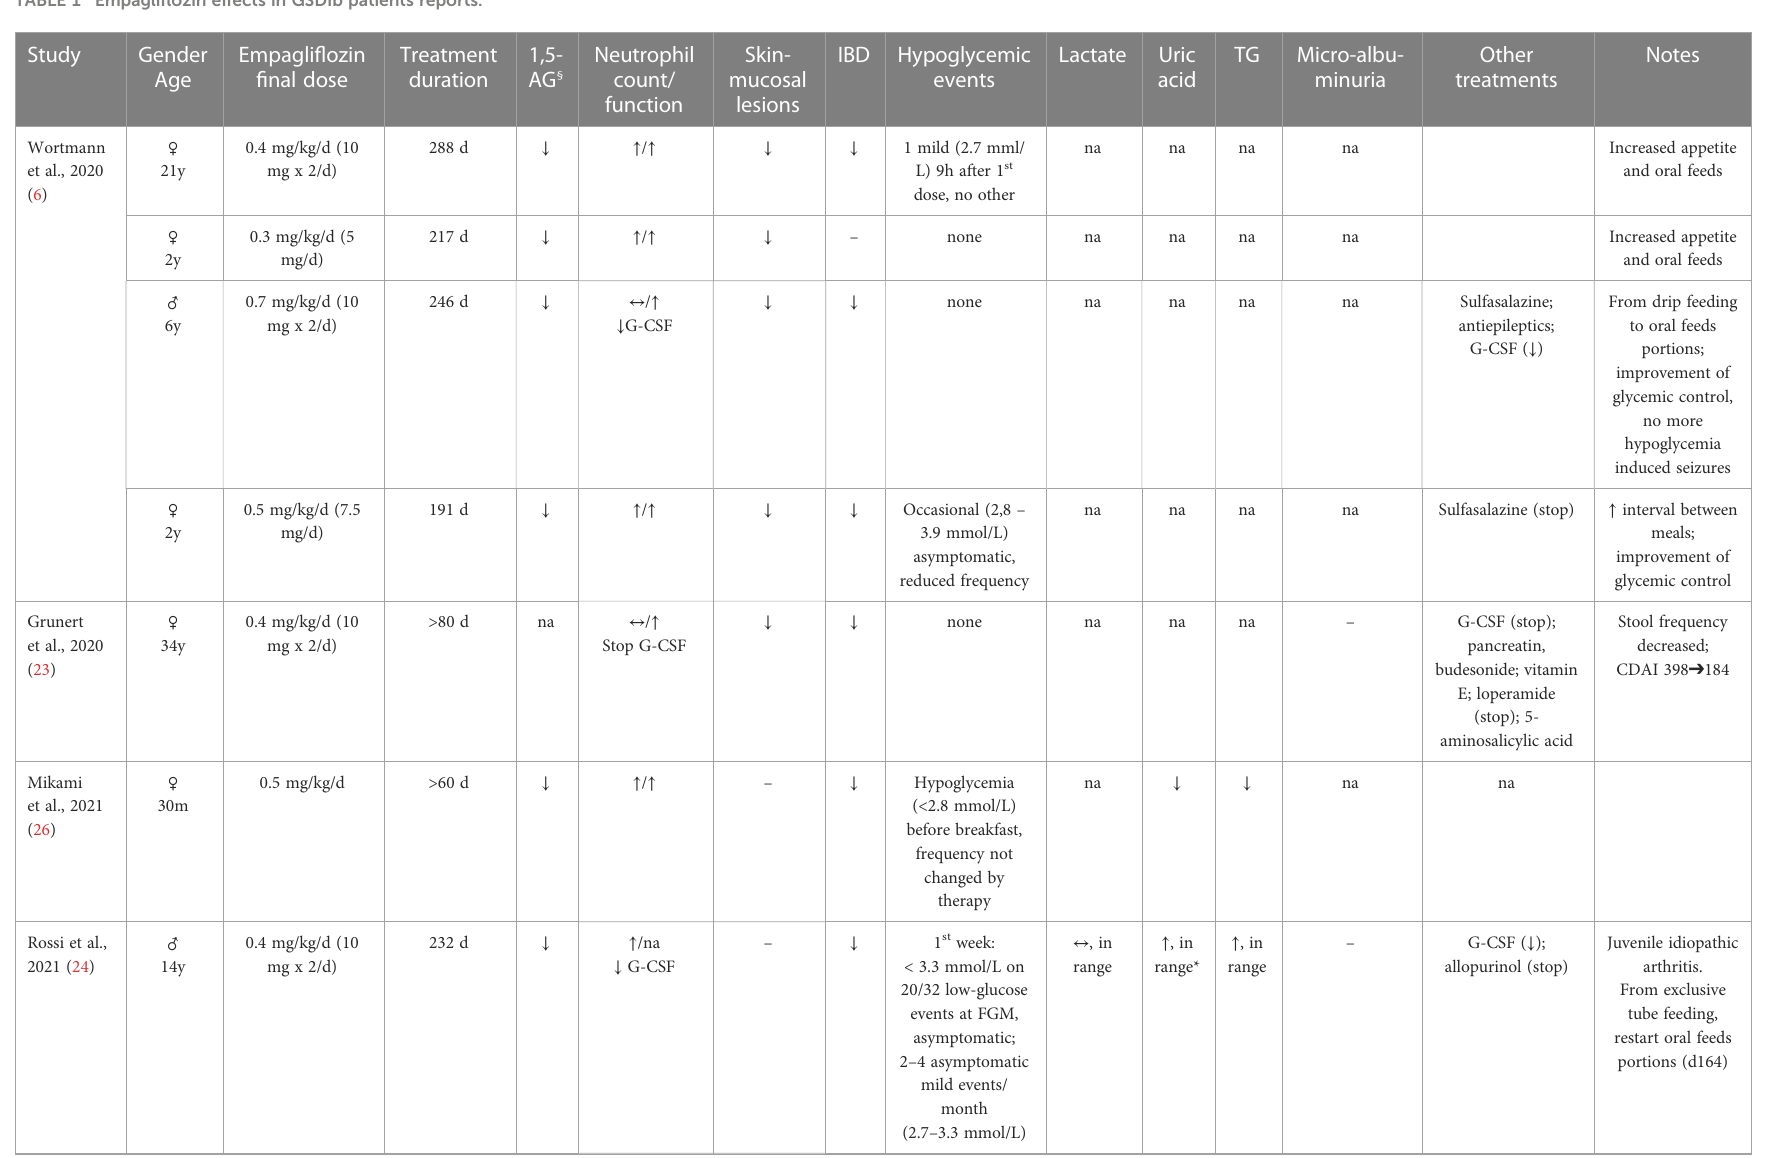
TABLE 1 Empagli fl ozin effects in GSDIb patients